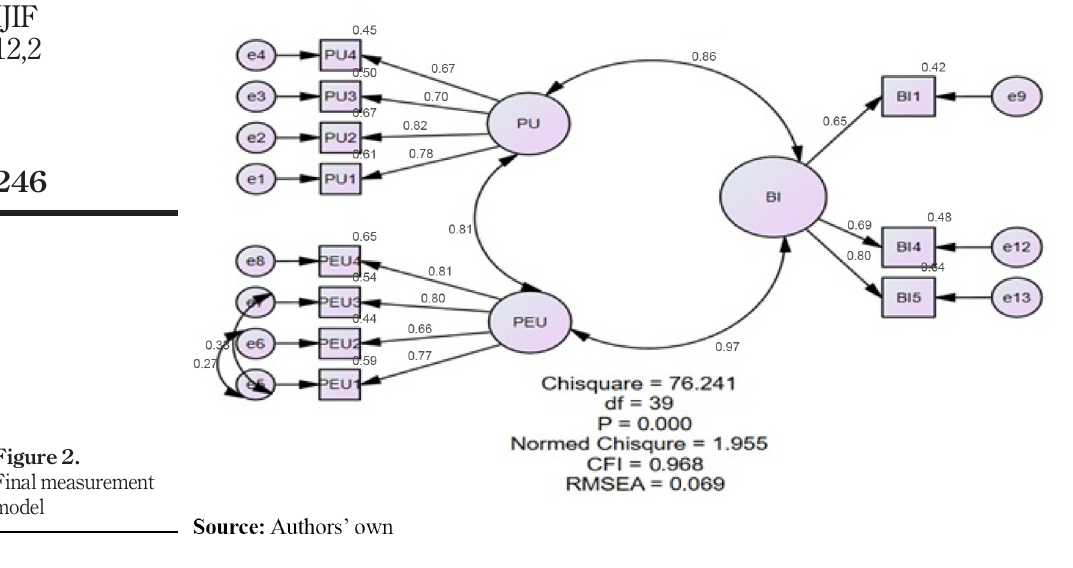
Figure 2. Final measurement model